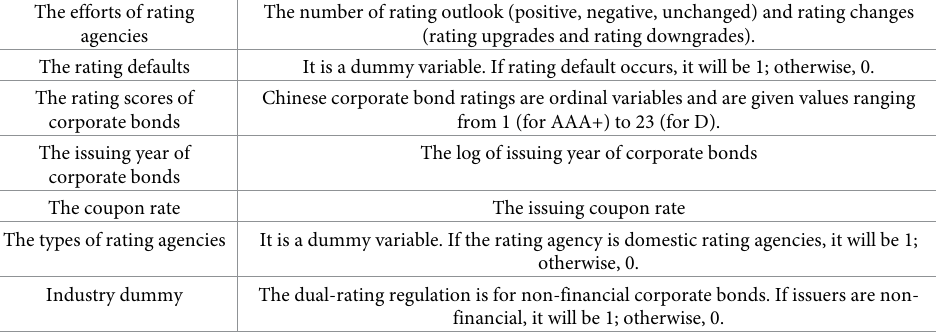
Table 3. The description of